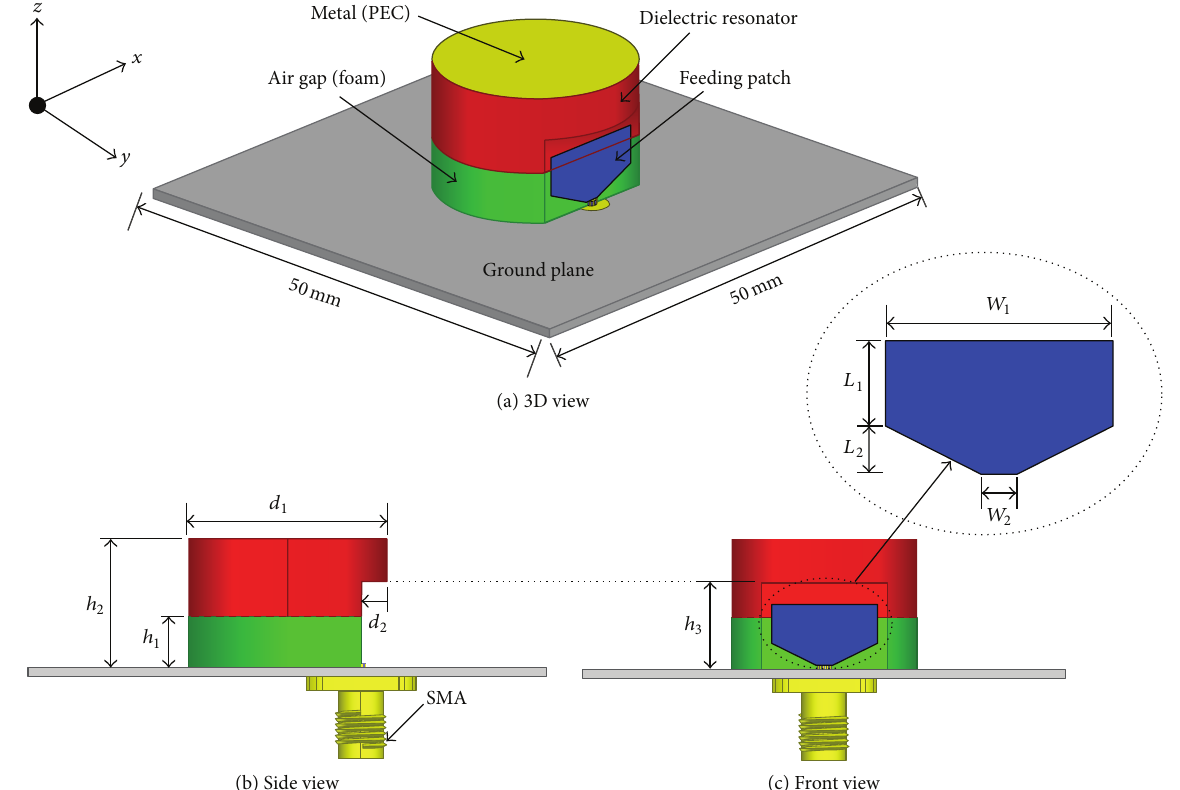
Figure 1: Geometry and configuration of the proposed